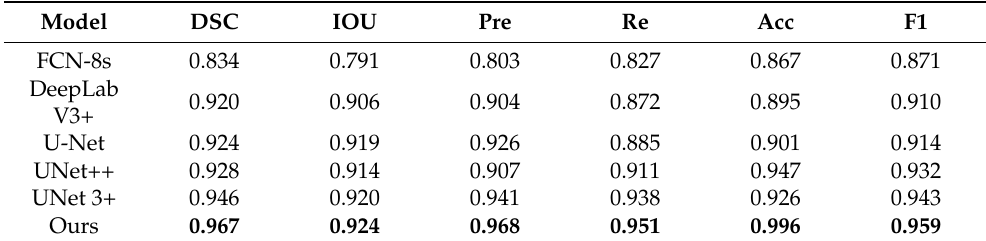
Table 3. Performance comparison of different classical segmentation methods in terms of evalua- tion metrics.